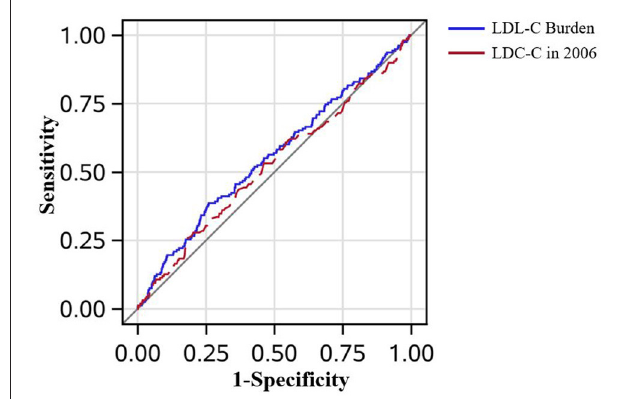
FIGURE 3 | The receiver operating characteristic curves in all patients. The low-density lipoprotein cholesterol (LDL-C) burden had the tendency to perform better than a single measure of LDL-C in predicting peripheral artery disease after adjustment for age, sex, smoker, drinker, body mass index, diabetes mellitus, hypertension, hypercholesterolemia, physical activity, and income status (0.554 vs . 0.524, P = 0.160).